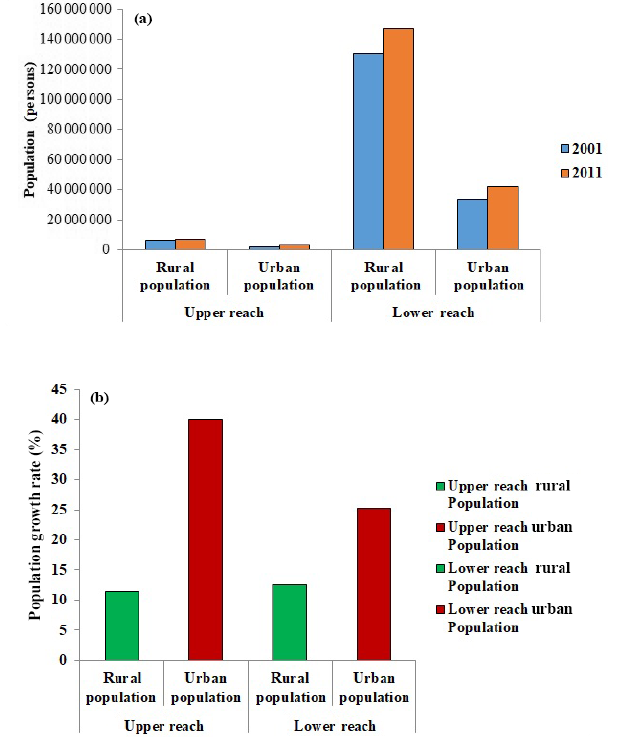
Figure 3. Growth in the rural and urban population of upper and lower reaches of the UGRB between 2001 and 2011. (a) Total pop- ulation and (b) population growth rate (PGR).